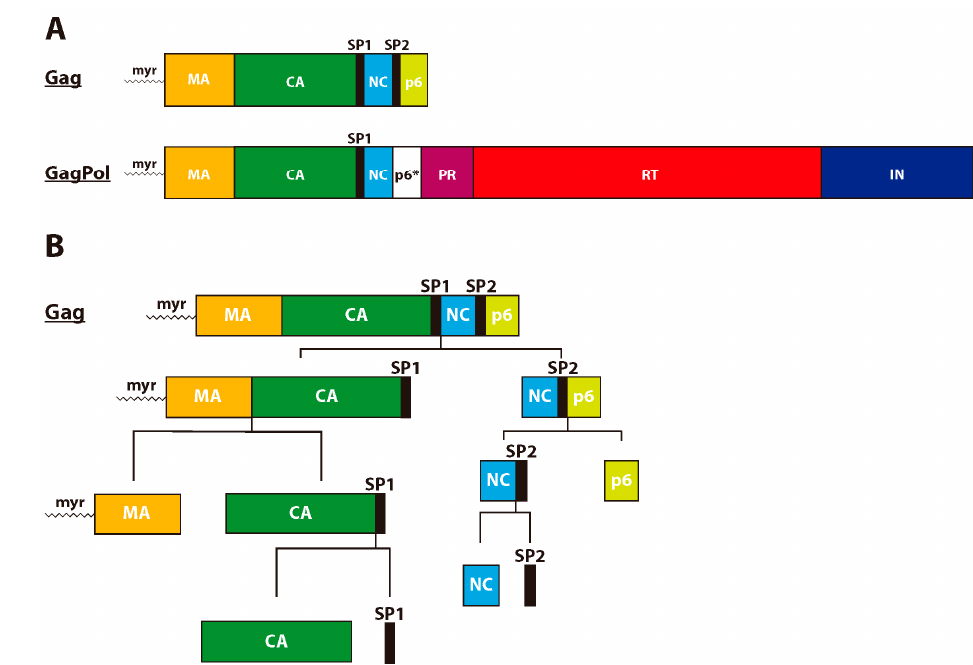
Figure 2. Organization of the Gag and GagPol polyproteins. ( A ) The Gag and GagPol polyproteins are expressed at roughly a 20:1 ratio during the late stages of HIV-1 infection as the result of a -1 frameshift during Gag translation. The Gag polyprotein contains the matrix (MA), capsid (CA), nucleocapsid (NC), and p6 domains with two spacer peptides (SP1 and SP2) flanking NC. The incorporation of GagPol into the Gag lattice provides immature virions with the necessary amount of viral enzymes (PR, reverse transcriptase (RT) and integrase (IN)) required for viral maturation, reverse transcription, and integration. p6* indicates the region of the pol open reading frame that overlaps with Gag-p6. The myristic acid moiety covalently attached to the N-terminus of the MA domain is indicated (myr). ( B ) The order of proteolytic cleavage events during maturation is depicted for the Gag polyprotein.